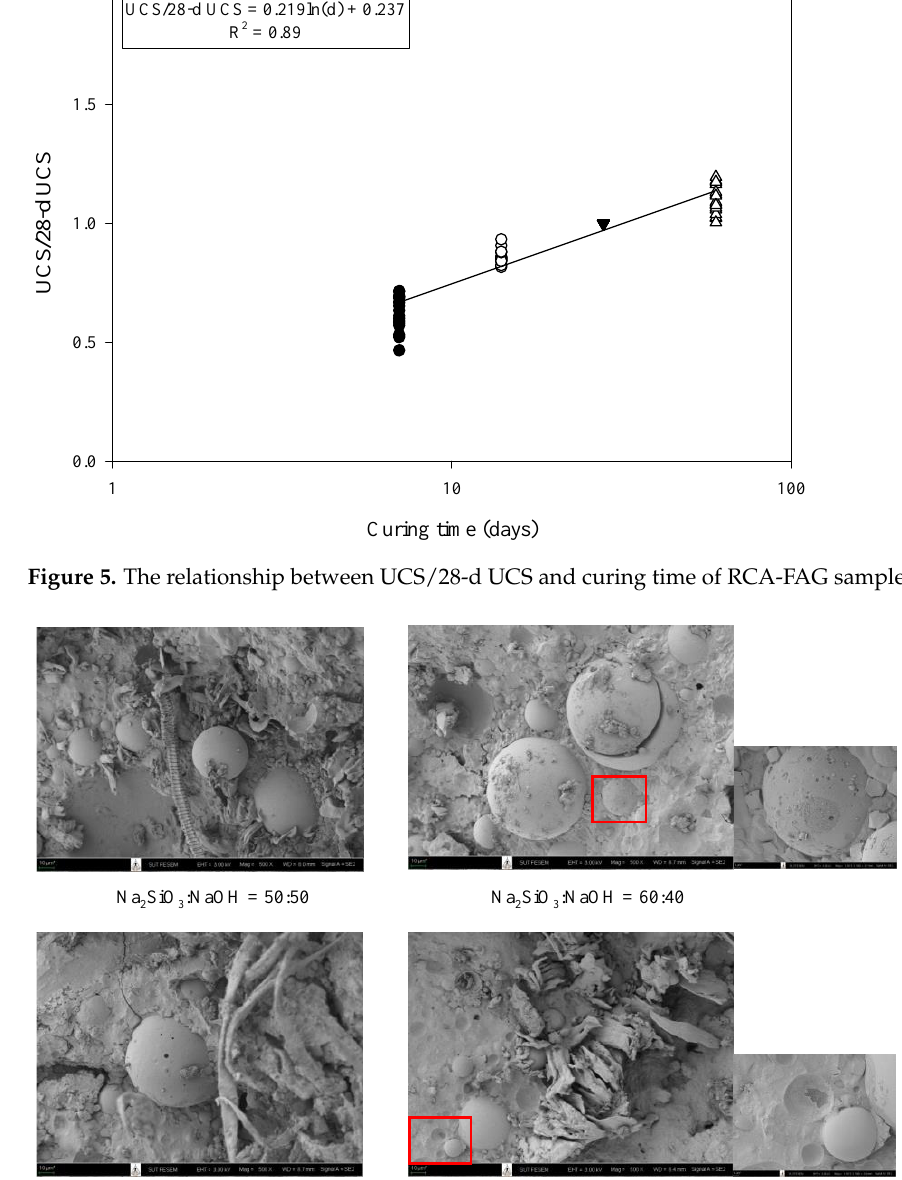
Figure 5. The relationship between UCS/28-d UCS and curing time of RCA-FAG samples.